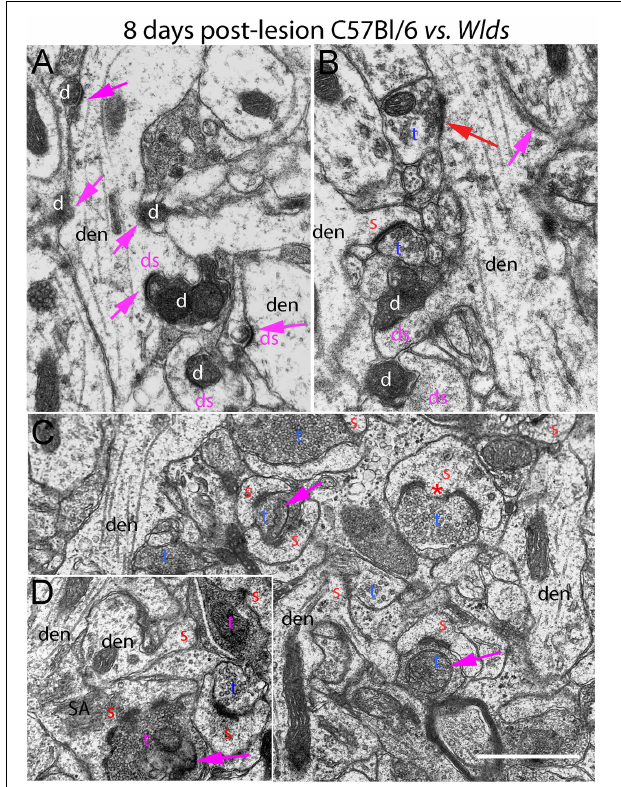
FIGURE 5 | Ultrastructure of synapses at 8 days post-lesion in C57Bl/6 and Wld s mice. (A,B) Dark-dense degeneration and collapsed spines at 8 days post-lesion in C57Bl/6 mice. Purple arrows indicate collapsed spines. Red arrow in (B) indicates non-degenerating synapse on a mound resembling a collapsed spine. (C) Non-degenerating synapses in the middle molecular layer of Wld s mice at 8 days postlesion. (D) Very large spine with complex spine apparatus (SA) and multiply segmented PSD. Spinules are marked by red asterisks. SA, spine apparatus; red s, spine head contacted by non-degenerating synapse; blue t, non-degenerating synaptic terminal; white d degenerating synaptic terminal; purple ds, spine contacted by degenerating presynaptic terminal; den, dendrite; pr, polyribosomes. Calibration bar in (A) = 0.25 µ m and applies to (A–D)